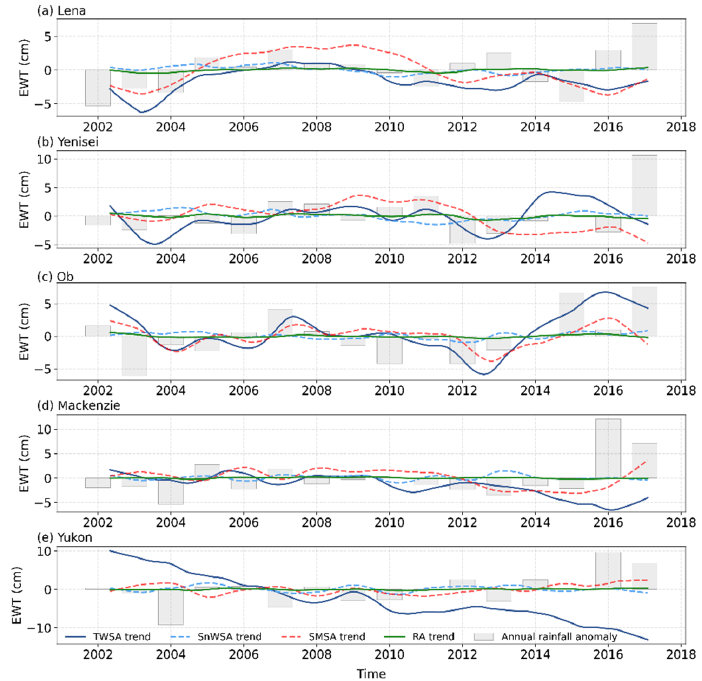
Figure 3. Trends in TWSA (deep blue line), SMSA (red dashed line), SnWSA (light blue dashed line), RA (green line), and annual rainfall anomaly (gray bar) from April 2002 to January 2017 in Lena, Yenisei, Ob, Mackenzie, and Yukon. EWT refers to equivalent water thickness.